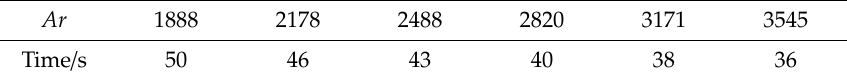
Table 2. The time for reaching the EPH at di ff erent Archimedes